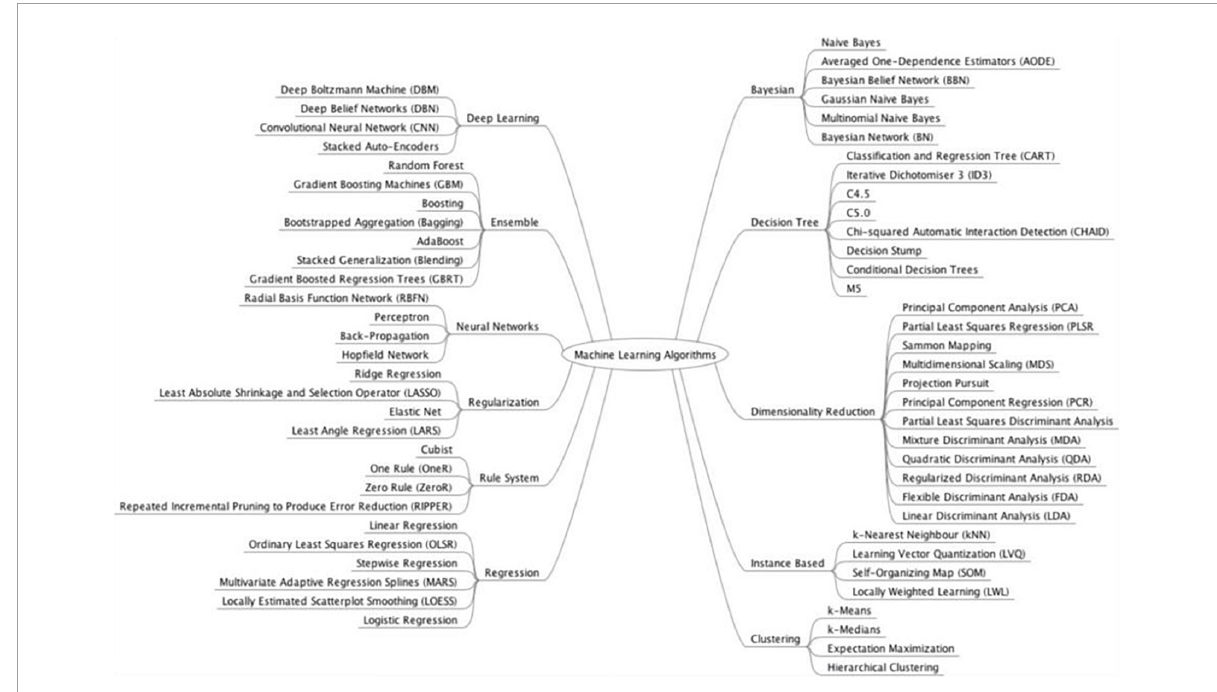
FIGURE1 Model classification. Source: Brownlee